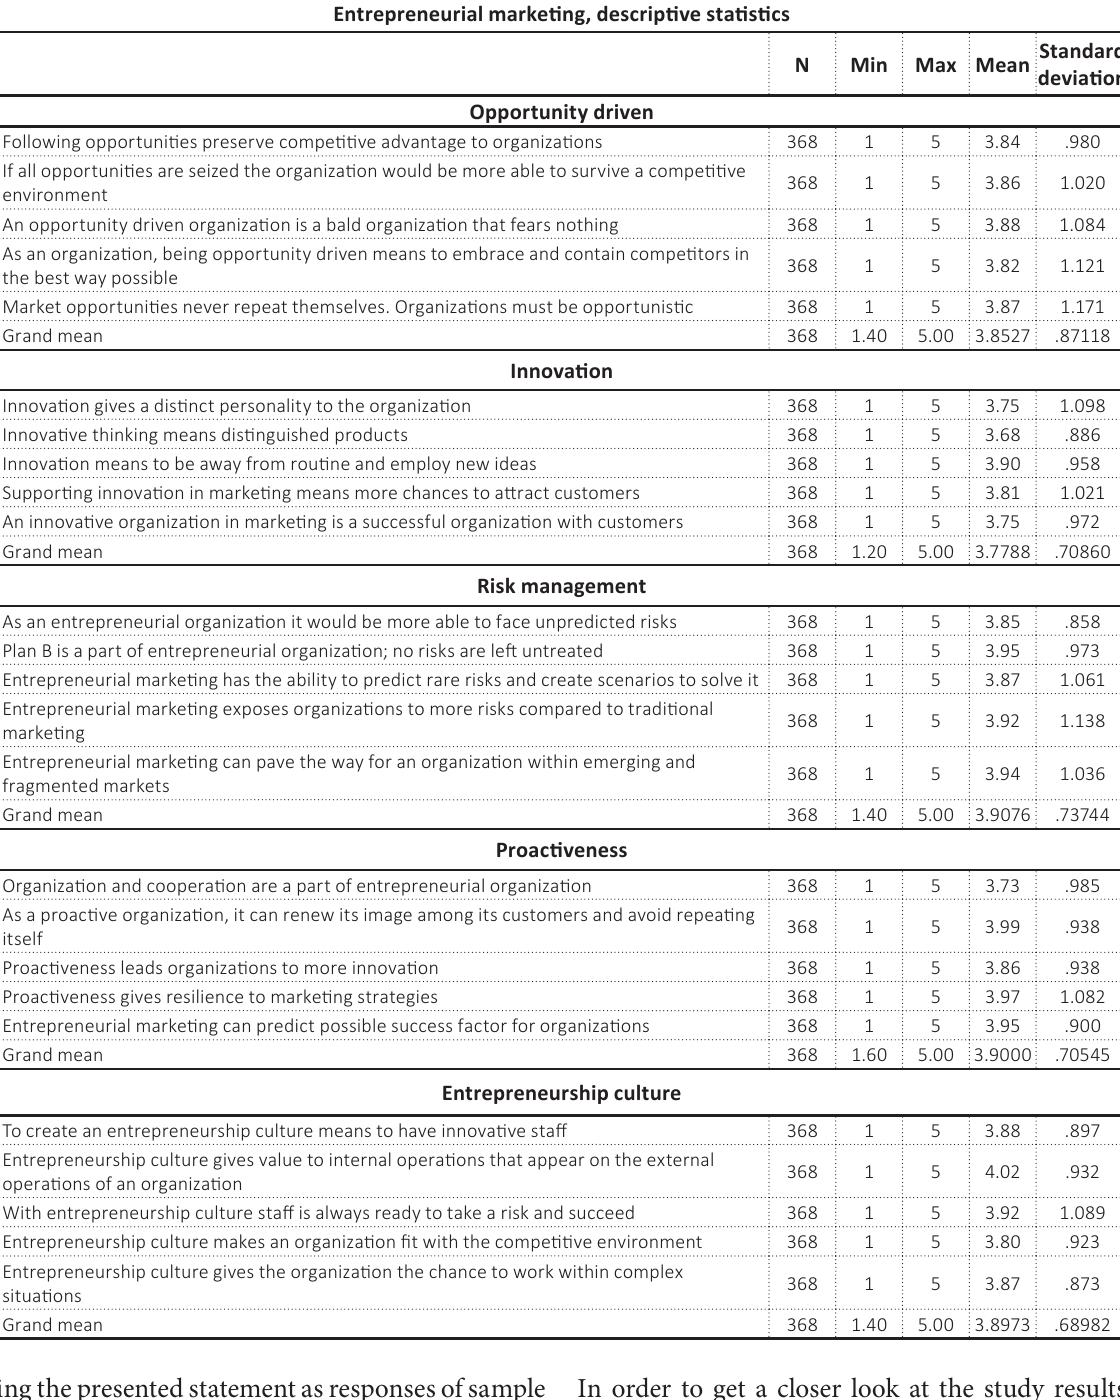
Table 2 (cont.). Questionnaire